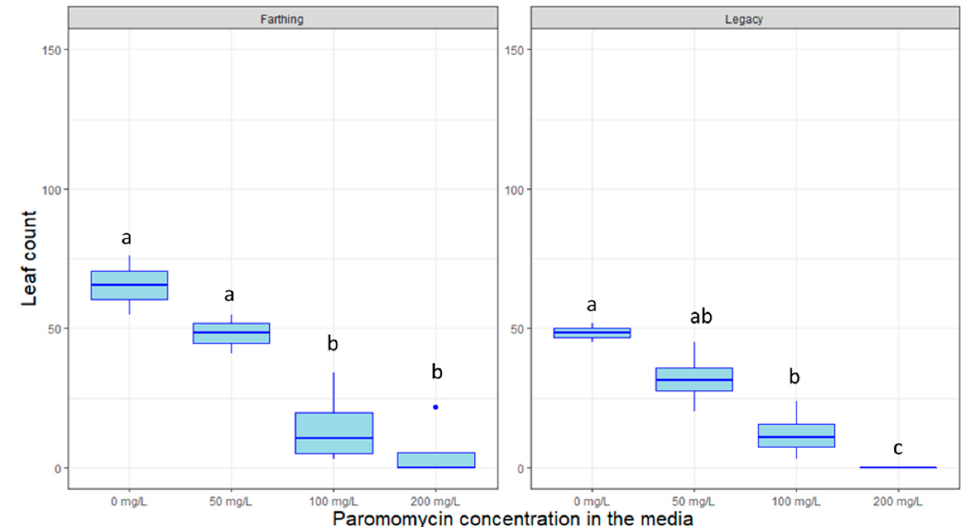
Figure 6. Box plot distribution of the effect of the selectable antibiotic marker kanamycin on leaf proliferation of two blueberry genotypes grown in tissue culture, “Farthing” ( left panels) and “Legacy” ( right panels). Letters above boxplots indicate multiple comparison test. Treatments with the same letters are not statistically different at alpha = 0.05.